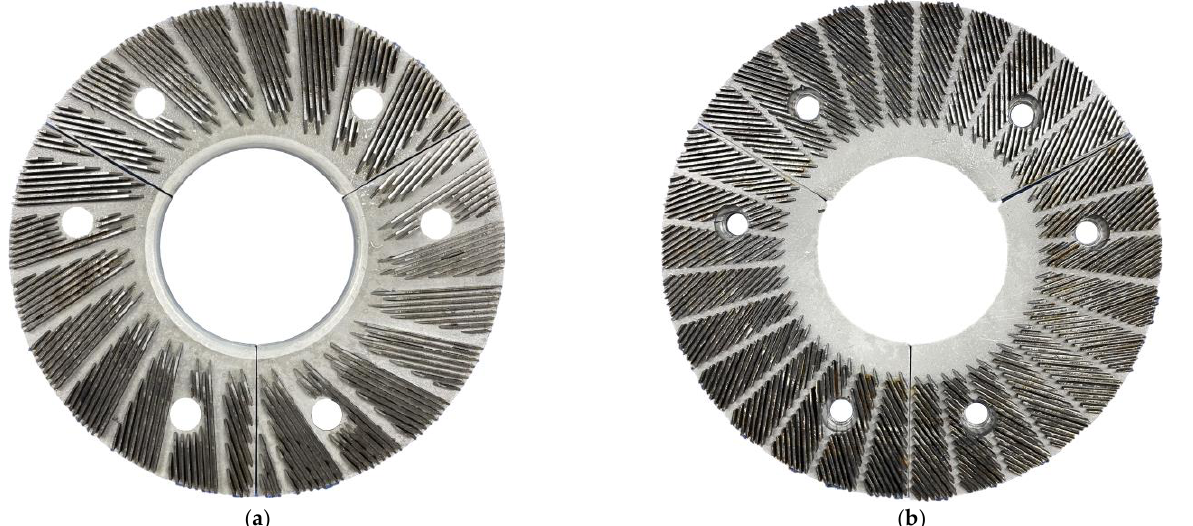
Figure 4. The novel plates with different bar fillings without the draft angle: ( a ) Plate A; ( b ) Plate